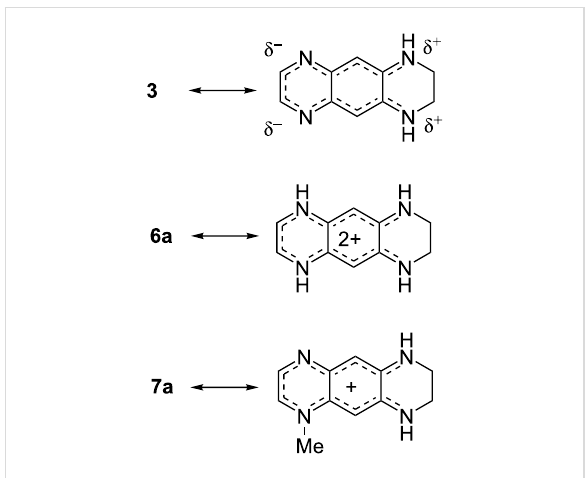
tion band at 467 nm corresponding to the monoprotonated species (blue curves, IBP1). Further addition of the acid leads to the appearance of another absorption band at 482 nm corre- sponding to the bis-protonated species (red curves, ABP2). The protonated species of 3 are not fluorescent. Minimum two Pekarian functions are needed to reproduce the band shape of the salts 6 in ethanol indicating that at least two electronic tran- sitions are involved (Supporting Information File 1, Figure S3).